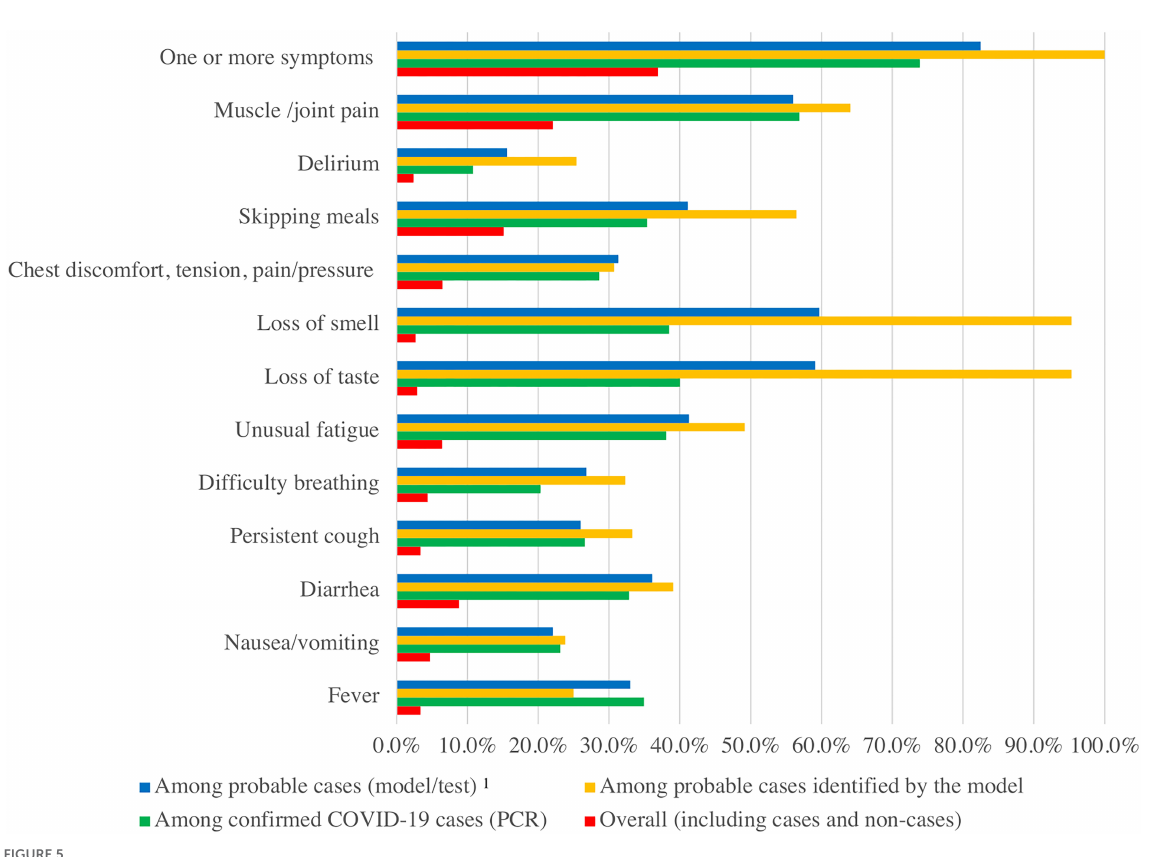
FIGURE5 Comparison of reported symptoms by types of cases. 1 Probable cases (including other tests and model based on key symptoms). Only those who reported symptoms are included in the figure, hence, the numbers may not add up. People report as many symptoms as they have, hence could exceed